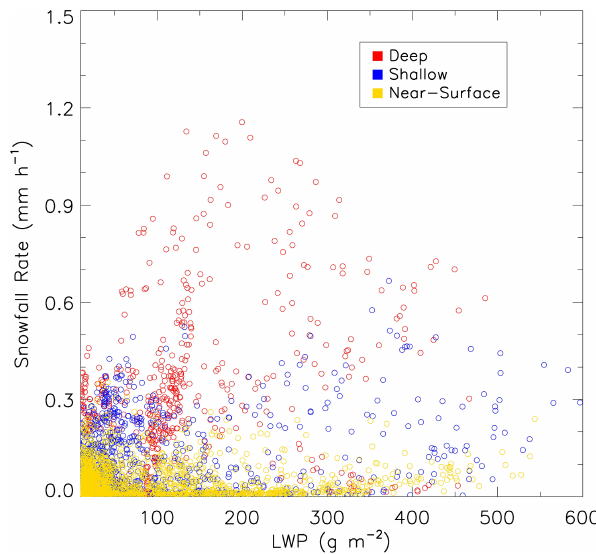
Figure 7. Scatterplot of the liquid water path and surface snowfall rate. Each point is an average of the 5min data. All observed data during the 2017–2018 winter are